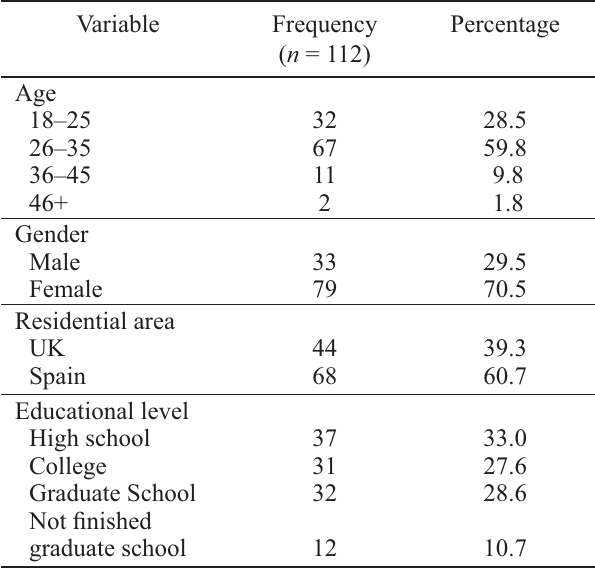
Table 1. Frequency distribution of demographics